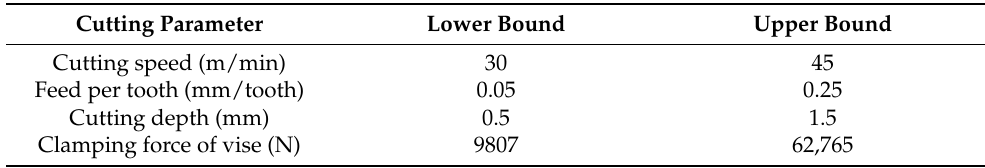
Table 6. Cutting parameters